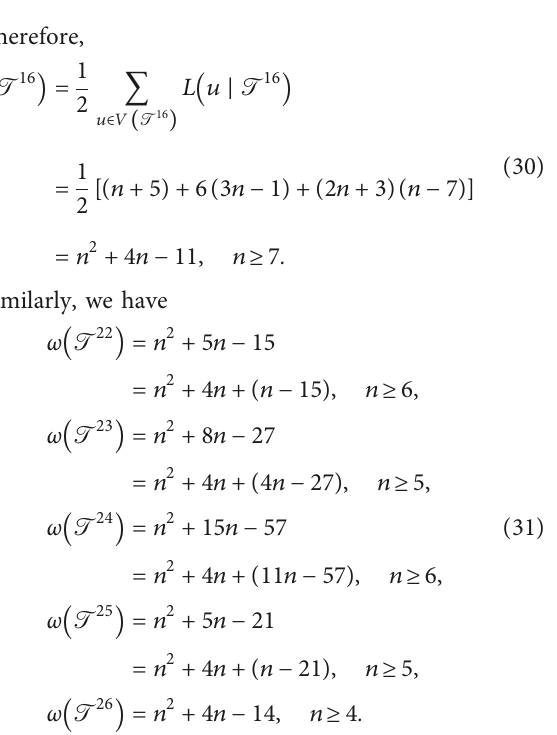
Figure 13: Graph T ( 3 )